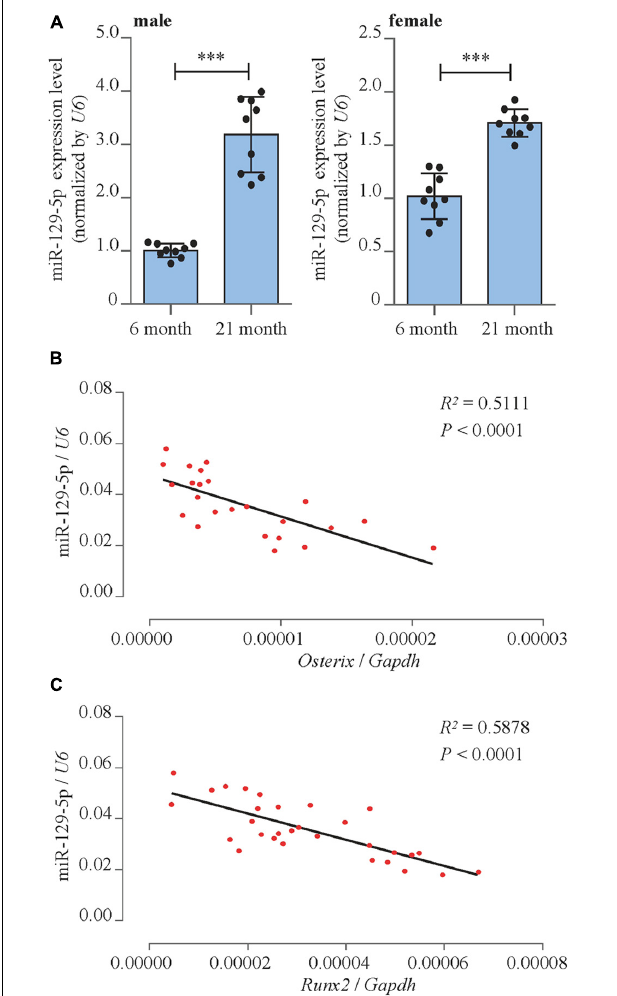
FIGURE 1 | miR-129-5p was associated with bone formation reduction. (A) Expression levels of miR-129-5p in BMSCs of 6- and 21-month male (left) and female (right) C57BL/6 mice, as detected by reverse transcriptase-polymerase chain reaction (RT-PCR; mean ± SD, ∗∗∗ P < 0.001). (B,C) Correlation analysis between miR-129-5p level and Oxterix or Runx2 mRNA levels in femur tissues from C57BL/6 mice, respectively, as detected by